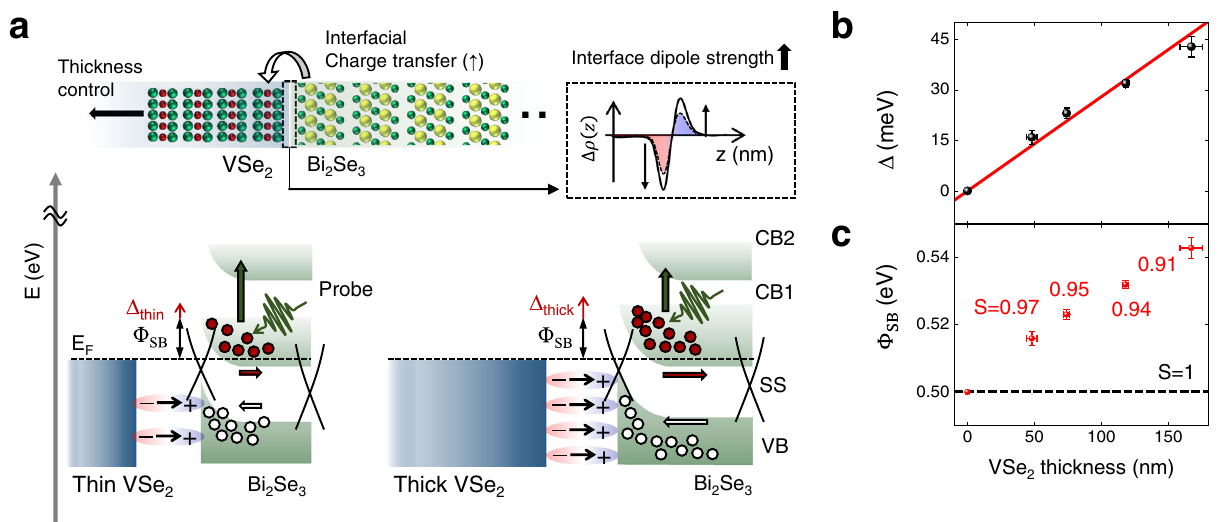
Fig. 5 Schematic of changes of the VSe2-thickness-dependent optical transition behavior in VBHs after contact with VSe2. a Schematic of charge transfer and redistribution due to the thermal equilibrium by the junction at VSe 2 /Bi 2 Se 3 and corresponding charge density near the junction interface. The increase of VSe 2 thickness requires a larger amount of electron from Bi 2 Se 3 for Fermi level alignment, leading to an increase of the interfacial dipole strength. Corresponding band diagram for VSe 2 /Bi 2 Se 3 junctions with thin and thick VSe 2 are illustrated with the electron Schottky barrier height (SBH, Ф 4 ) as indicated by black and red vertical arrows, respectively. The CB1/CB2, VB, and SS imply the fi rst/second conduction band, SB ) and band offset ( valence band, and surface state of Bi 2 Se 3 , respectively. The green vertical arrow indicates optical transitions corresponding to probe energies. b VSe 2 - thickness-dependent band offset ( 4 ) by dipole interactions and c estimated electron Ф SB . The expected pinning factor S is listed. The error bars in ( b ) and ( c ) come from the standard error for fi tted values of E opt in Fig.